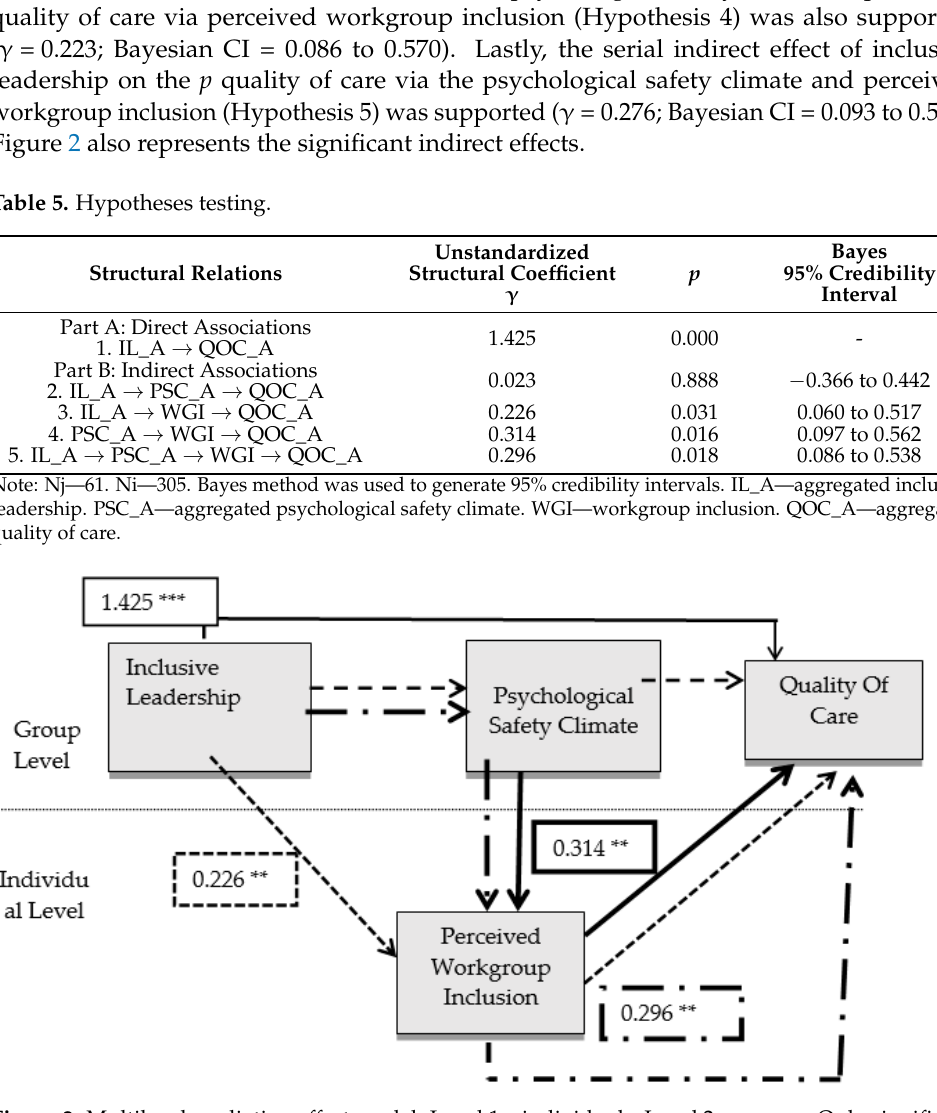
Figure 2. Multilevel mediating effect model. Level 1—individuals; Level 2—groups. Only significant coefficients are shown; ** p < 0.05, *** p < 0.001.